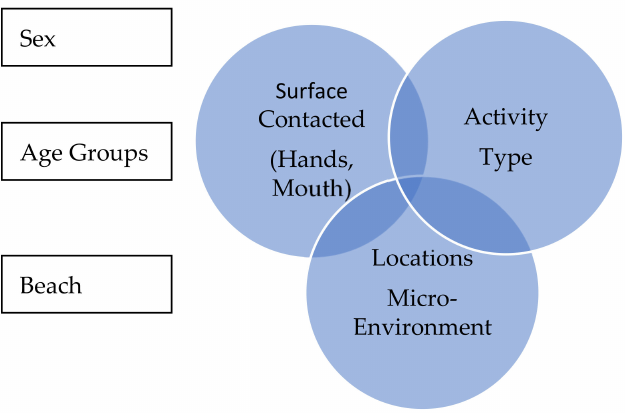
Figure 3. Overlapping Location, Activity and Surface Contacted to examine Trends.